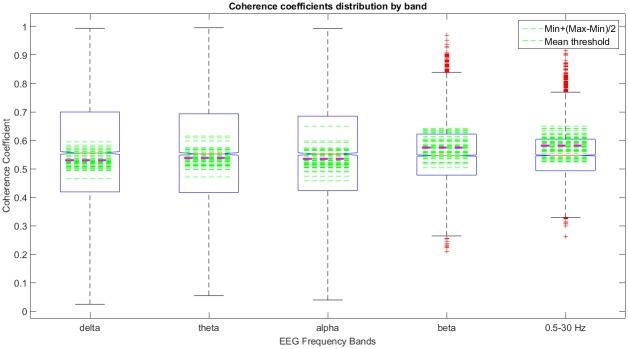
An example of the coherence coefficients distribution in all frequency bands.The green lines represent the proposed threshold per subject, which lie inside the 2nd and 3rd quartiles for δ, θ and α frequency bands, taking into account more or less the 50% of the coherence values sample. For β and 0.5 − 30 Hz frequency bands there are some thresholds outside the blue box which lie inside the 4th quartile taking into account less than the 25% of the coherence values sample. The magenta dashed line indicates the mean value of thresholds among the subjects.